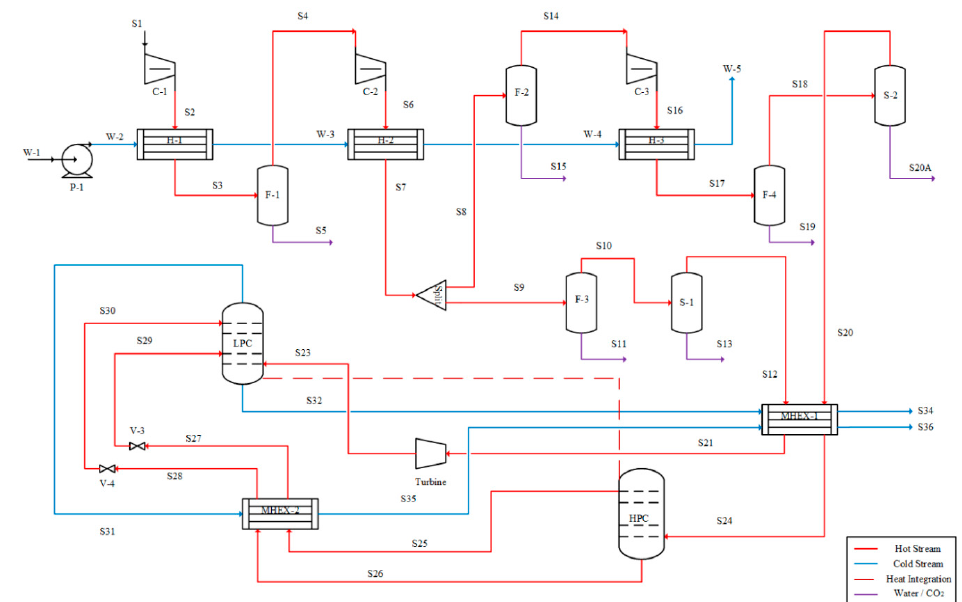
Figure 3. Process flow diagram of the ASU configuration C3.